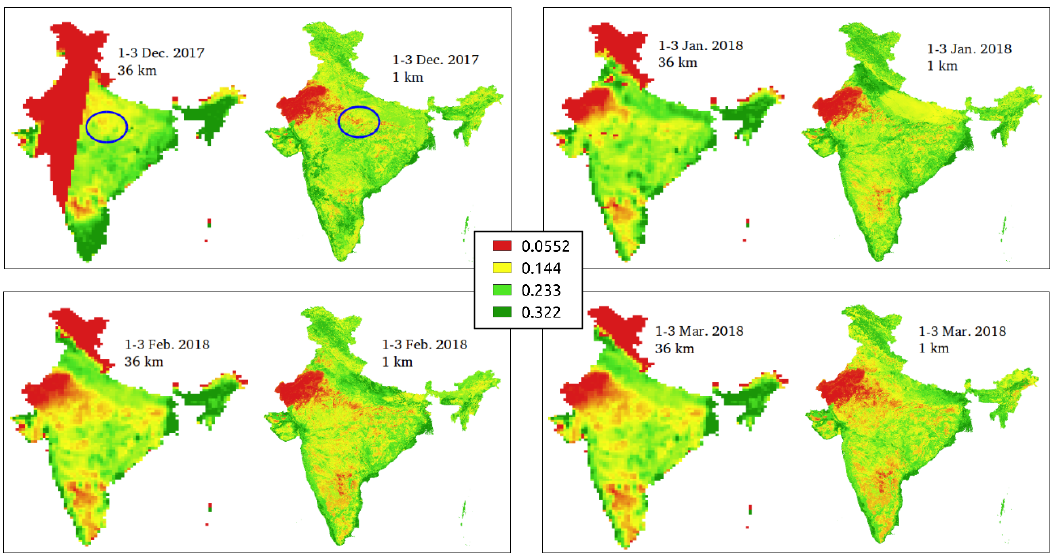
Figure 4. SMAP 36 km vs downscaled 1 km soil moisture maps for